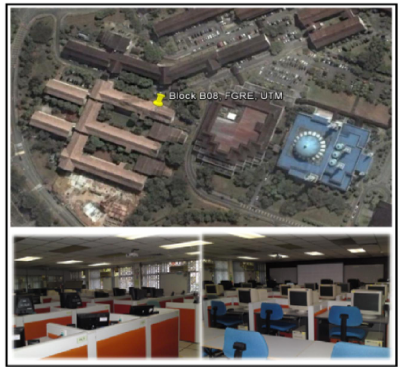
Figure 3. Location of block B08 in UTM campus